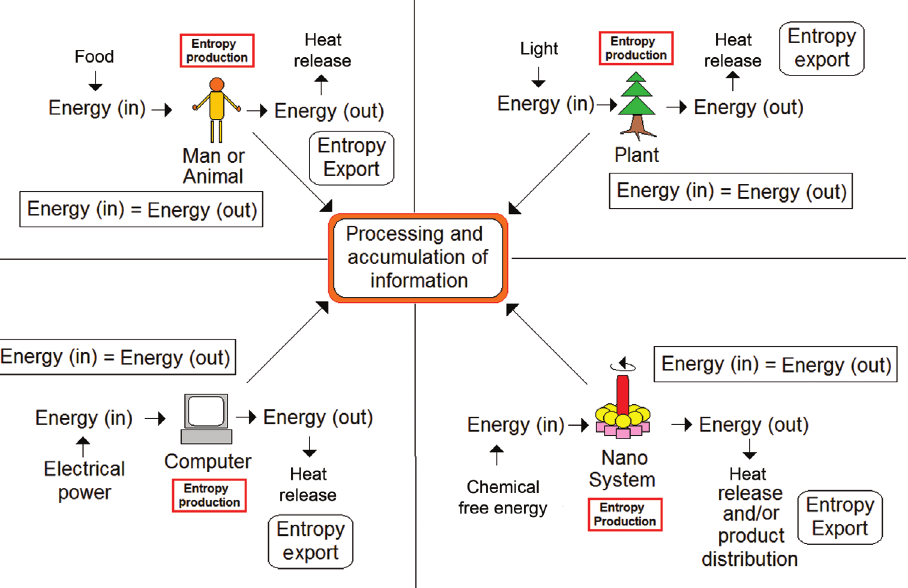
Figure 2 Entropy production, entropy export, and accumulation of information in self-organized thermodynamically open